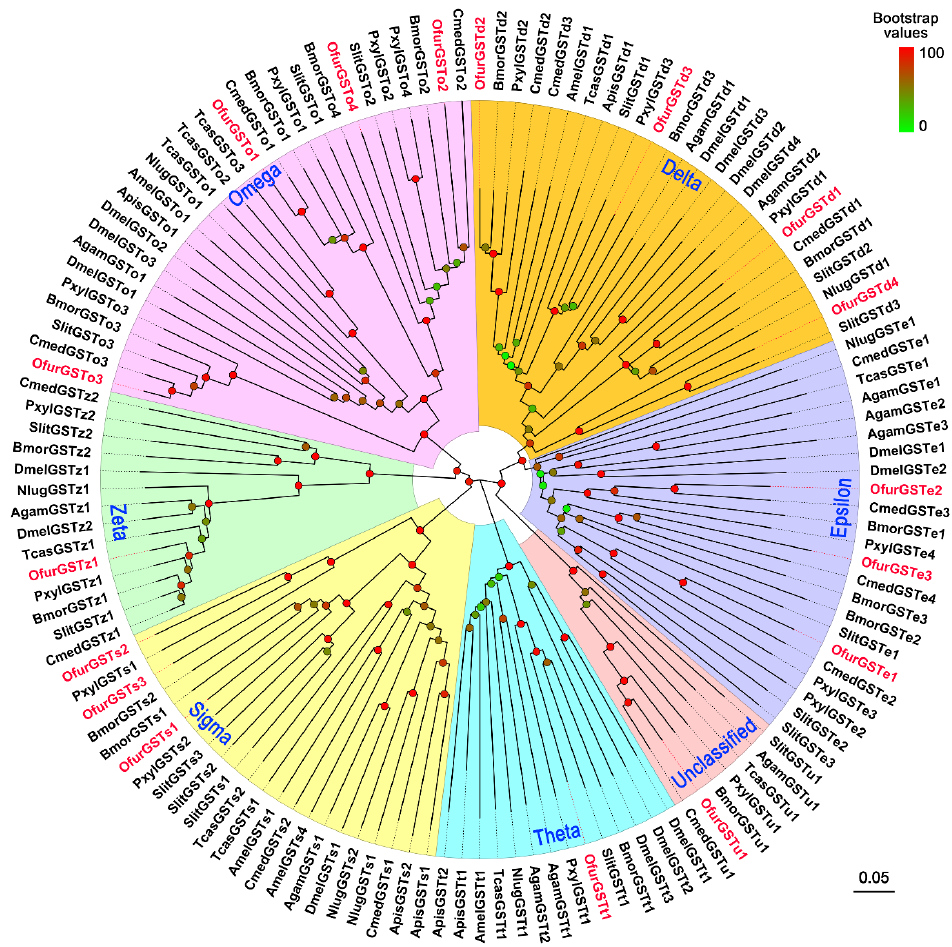
Figure 3. Phylogenetic analysis of GSTs from Ostrinia furnacalis (Ofur-prefix), Bombyx mori (Bmor), Plutella xylostella (Pxyl), Cnaphalocrocis medinalis (Cmed), Spodoptera litura (Slit), Drosophila melanogaster (Dmel), Anopheles gambiae (Agam), Tribolium castaneum (Tcas), Apis mellifera (Amel), Nilaparvata lugens (Nlug), and Acyrthosiphon pisum (Apis). Bootstrap support values are indicated by coloring from green (0) to red (100) on each node. Insect GSTs are classified into six classes (delta, epsilon, omega, sigma, theta, and zeta) and an “unclassified” clade. The O. furnacalis GSTs are colored red. GenBank accession numbers of sequences used are listed in Table S1.